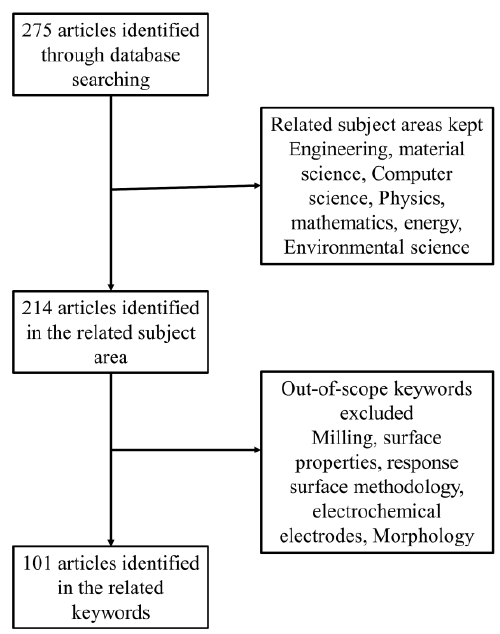
Figure 1. Methodology applied to identify 101 articles.